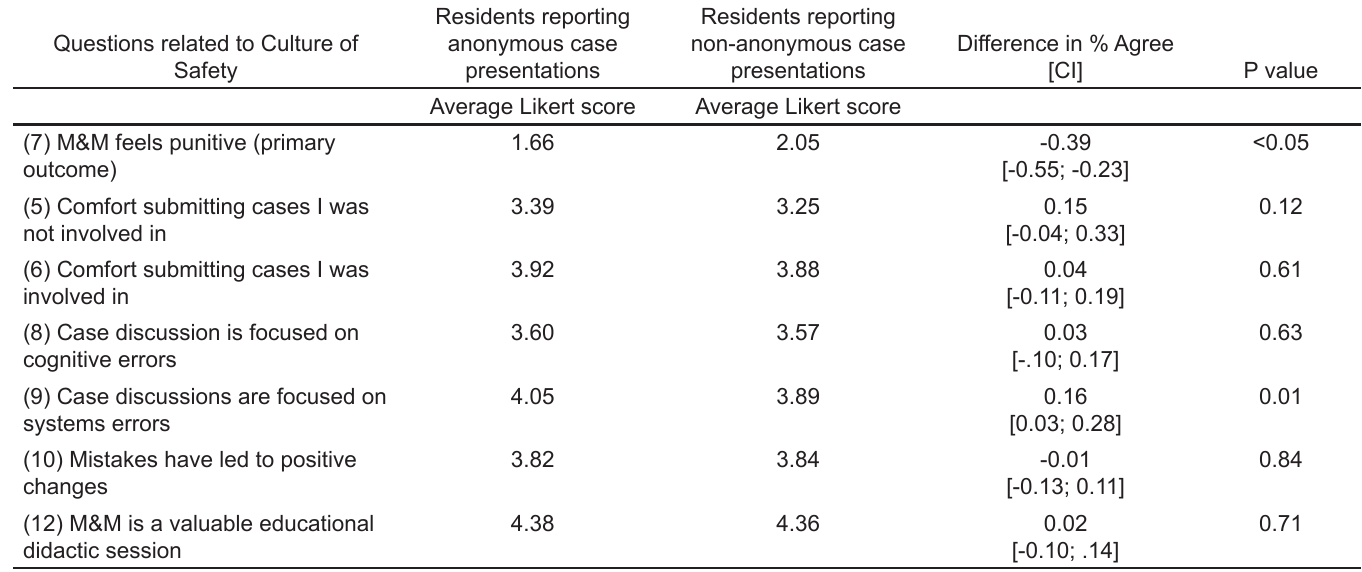
Table 3. Primary and secondary